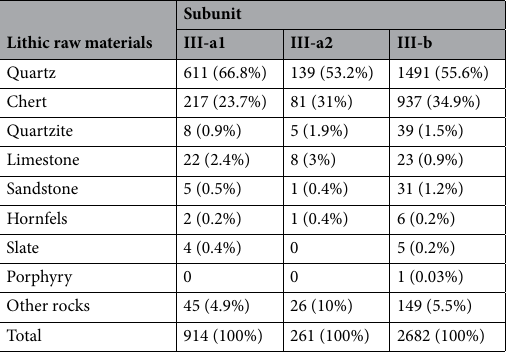
Table 3. Frequency of lithic raw materials in subunits III-a1, III-a2 and III-b.